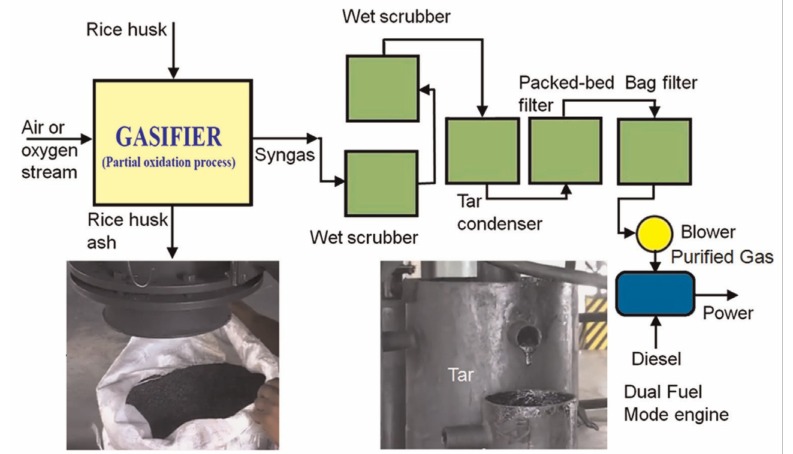
Figure 3. Obtaining of RHA via a gasifier power system